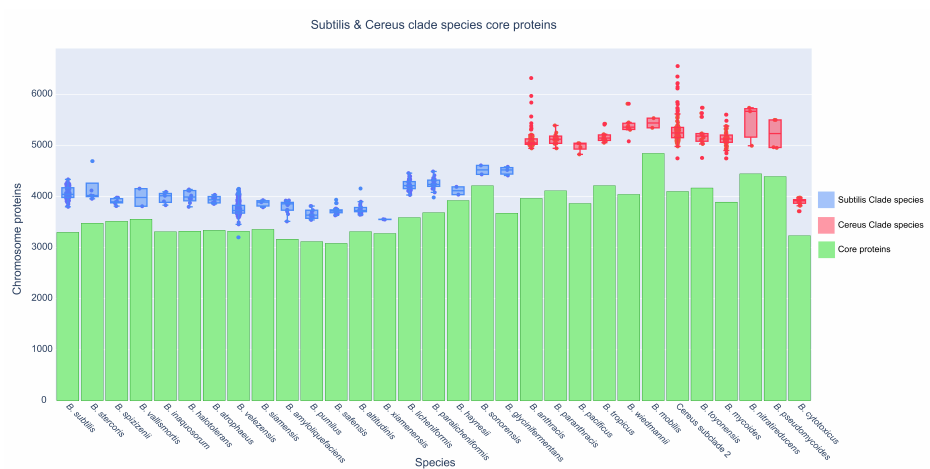
Figure 4. Boxplot of the total number of proteins (y-axis) for every available strain (dot—each genome) of a species (x-axis) and its normalized core proteome (green